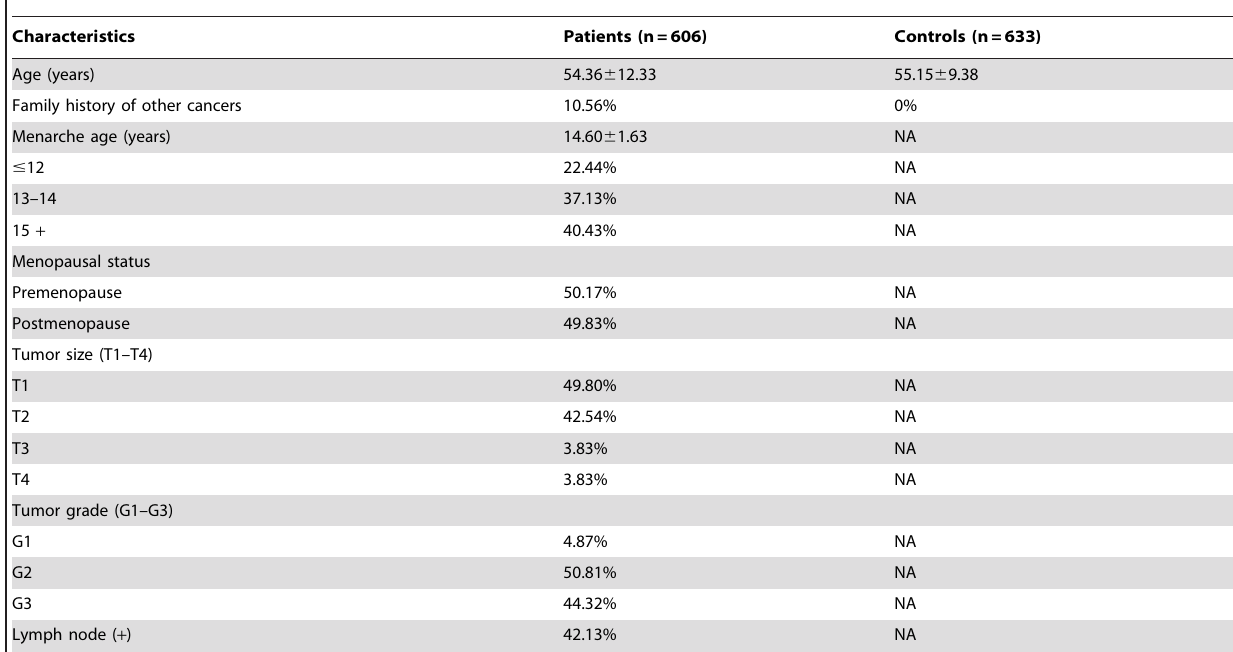
Table 1. The baseline characteristics of all study participants.